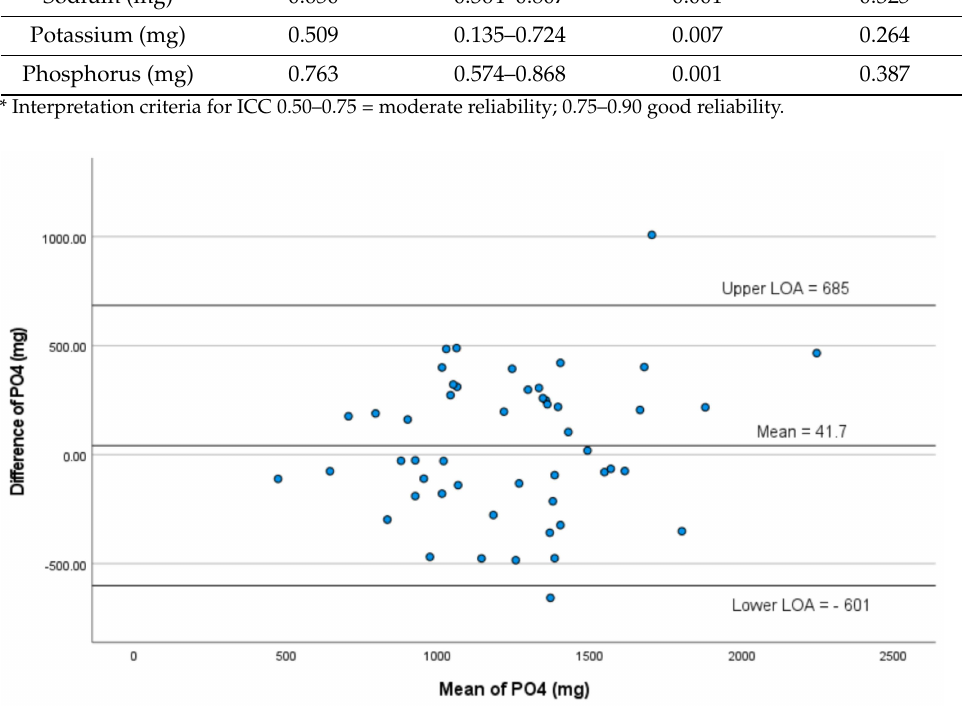
Figure 3. Bland–Altman plots of agreement between 24 hr multi pass recall and P-FFQ for di- etary